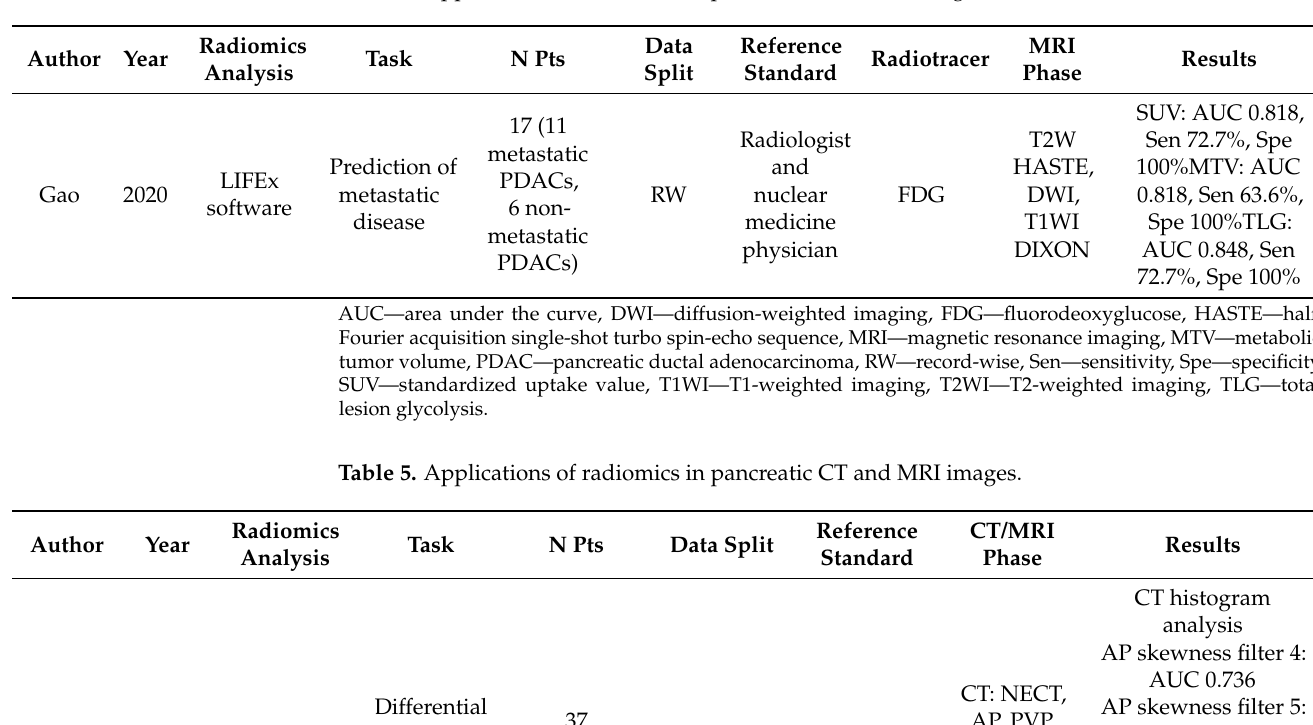
Table 4. Applications of radiomics in pancreatic PET-MRI images.